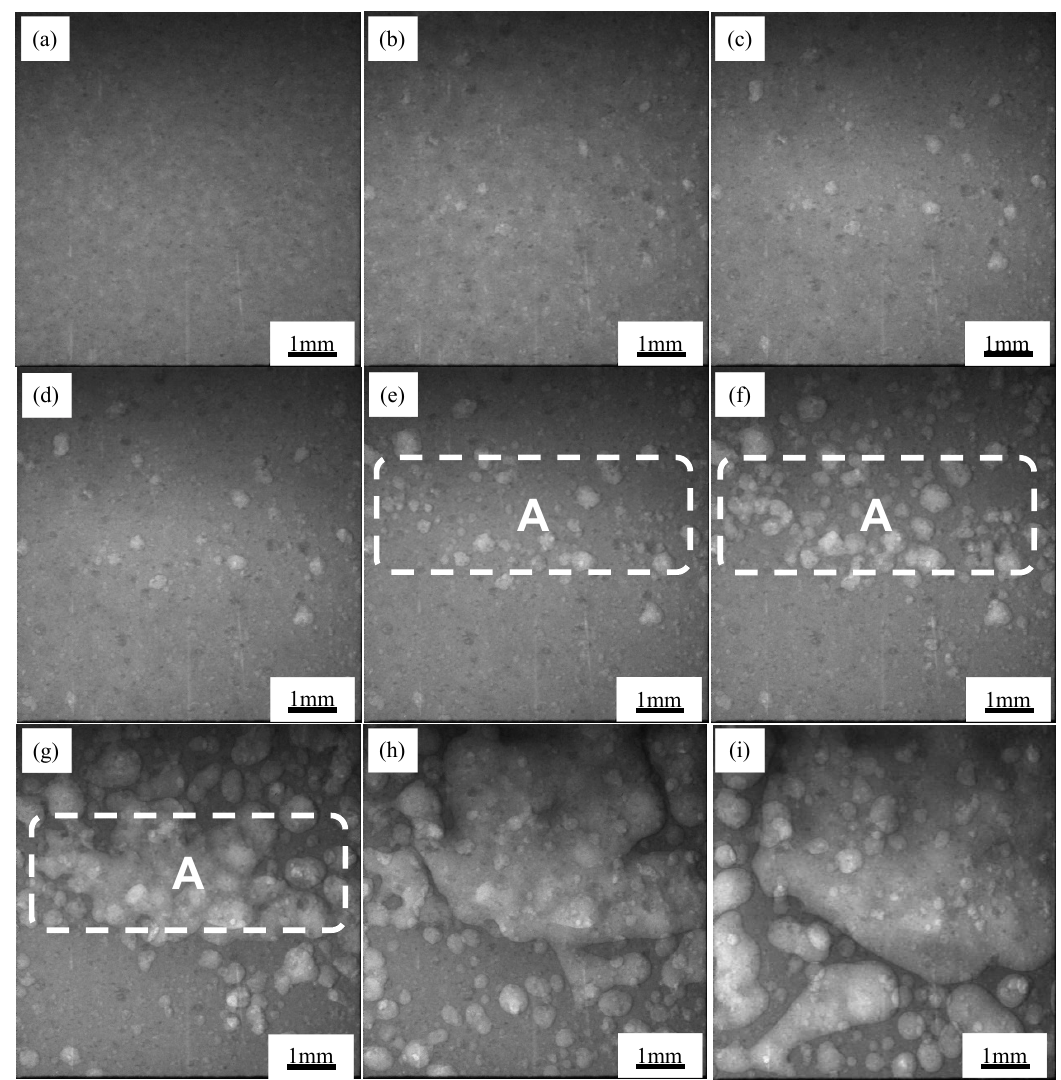
Figure 3. Foaming process of aluminum foam made of pure Al: ( a ) <607 °C; ( b ) 627 °C; ( c ) 630 °C; ( d ) 652 °C; ( e ) 654 °C; ( f ) 656 °C; ( g ) 658 °C; ( h ) 660 °C; and ( i ) 663 °C.